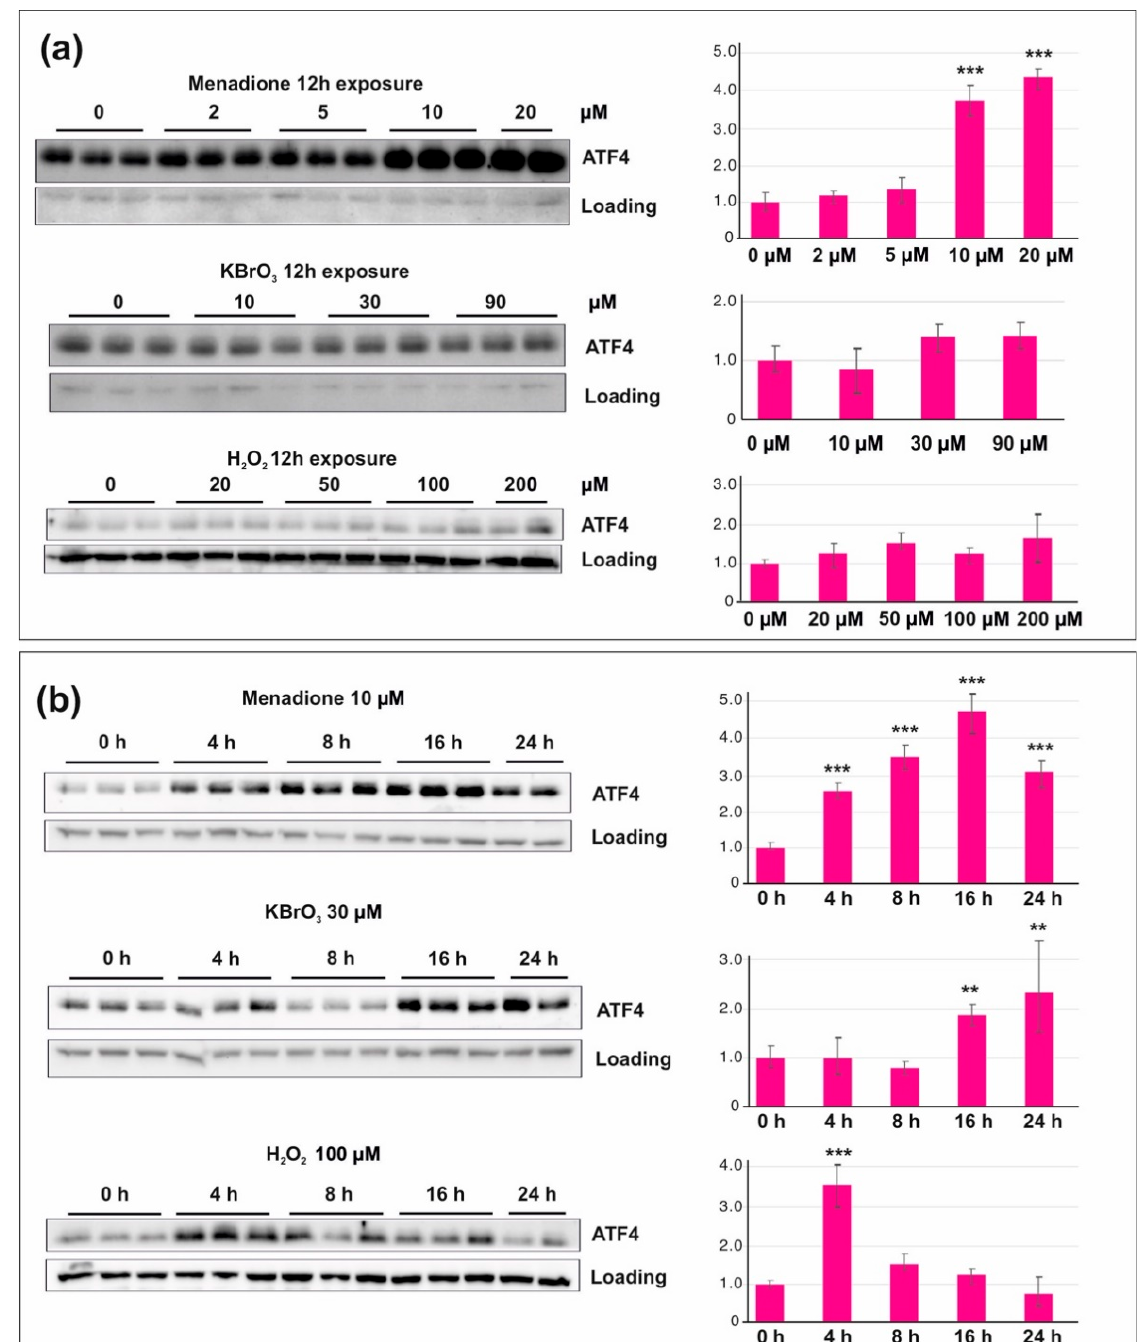
Figure 2. Integrated stress response (ISR) in HEK293T cells exposed to menadione, KBrO 3 , or H 2 O 2 . ( a ) ATF4 levels after 12 h exposure to increasing concentrations of oxidants. Note the dramatic increase after menadione treatment. ( b ) Menadione causes a rapid and persistent induction of ISR, whereas KBrO 3 treated cells show a delayed response only after 16 h exposure. The H 2 O 2 treatment results in a transient increase in ATF4 levels after 4 h exposure. VDAC and actin were used as a loading control. ** p < 0.01, *** p < 0.001 ANOVA/Tukey, compared with the untreated control.